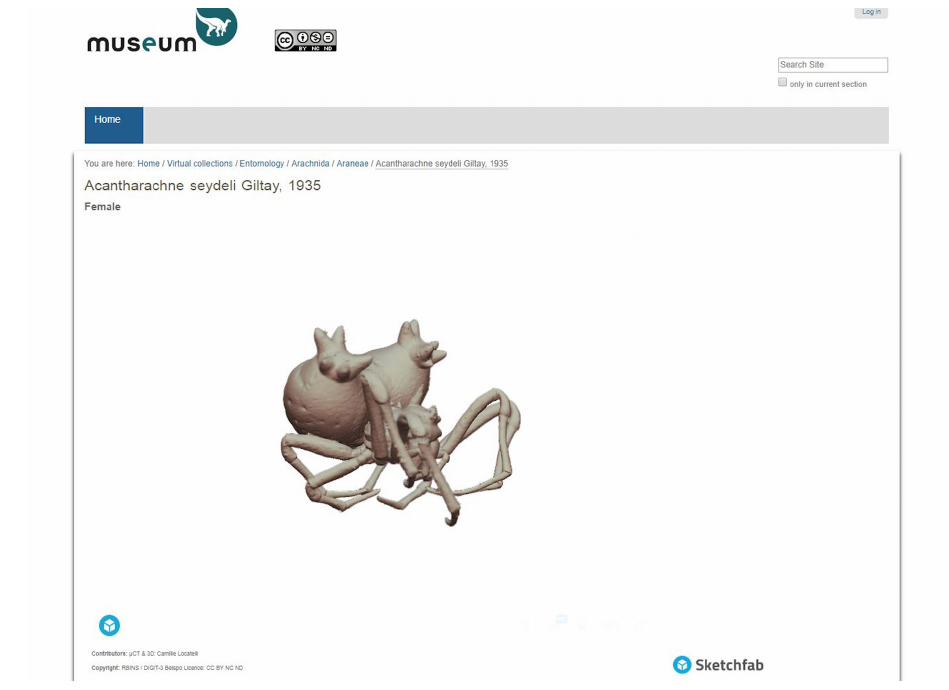
Fig. 8.4. Virtual collections page of RBINS: Specimen view.